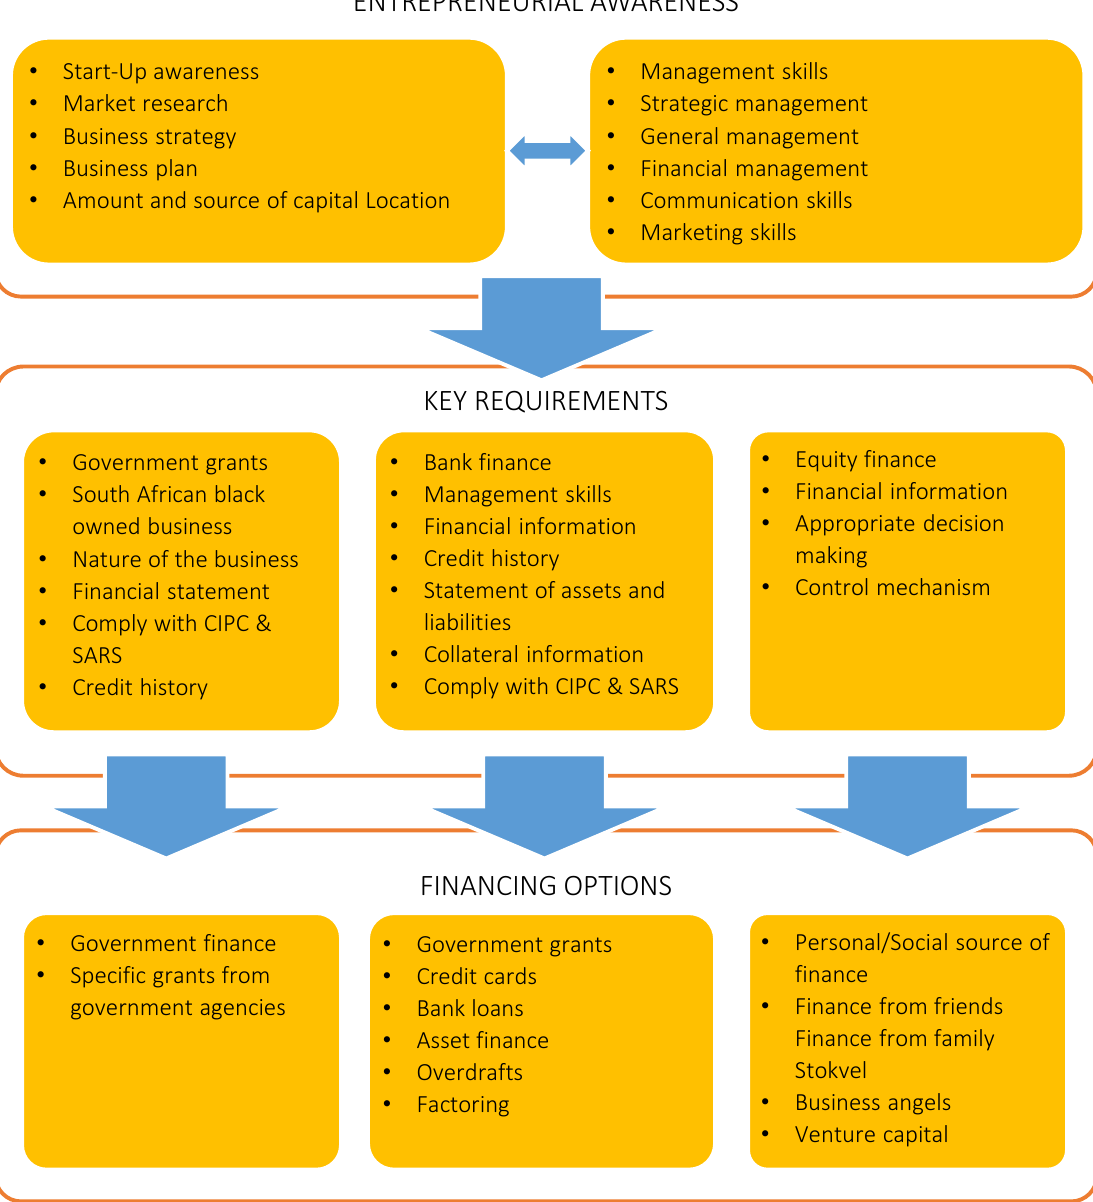
Figure 2. Financing framework for SME’s access to external